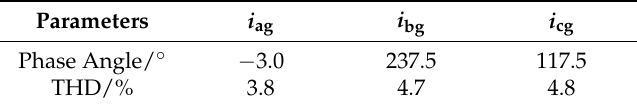
Table 1. The phase angles and THDs of the three-phase current.